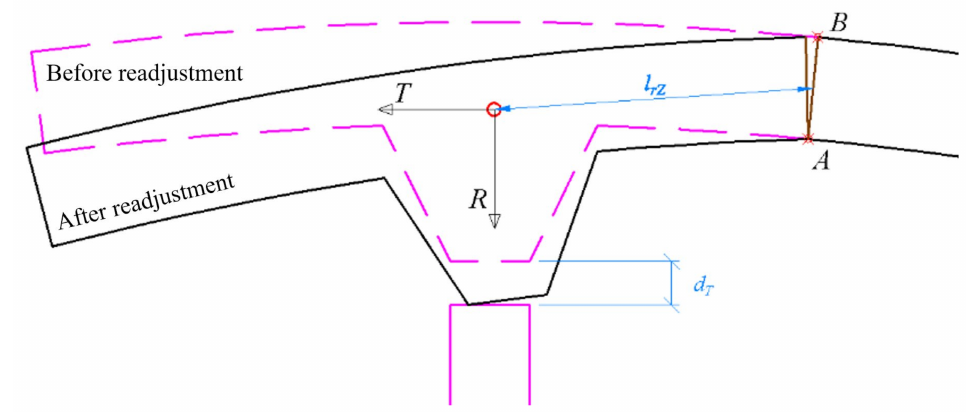
Figure 13. Segment attitude adjustment of the T1 block before installing the LZ block.